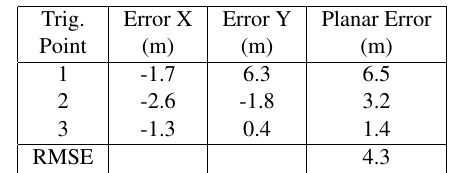
Table 3. The errors of CPs for the indirect method applied to 2 corrected maps in Attiki test site.